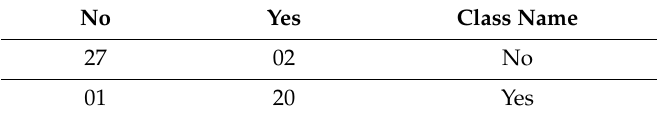
Table 13. Matrix with reduced dimensions for fold 2.